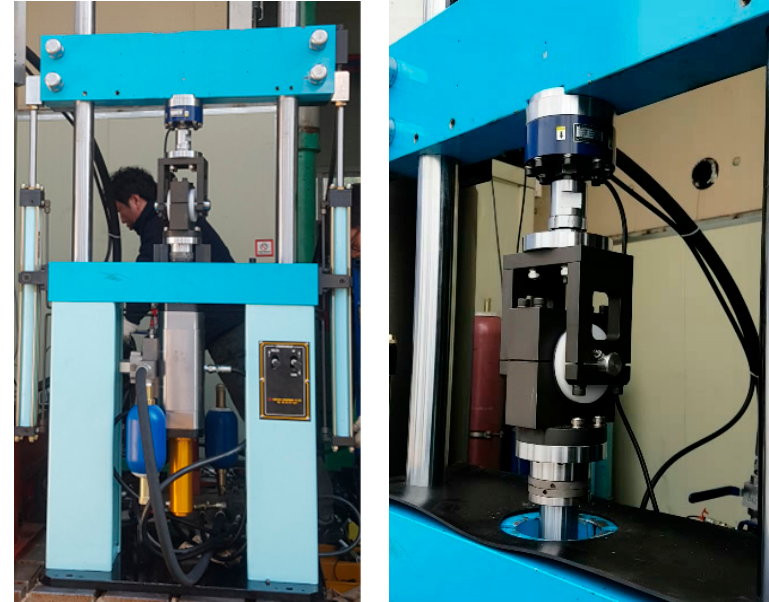
Figure 2. Fatigue test equipment equipped with hydraulic servo actuators developed under test.